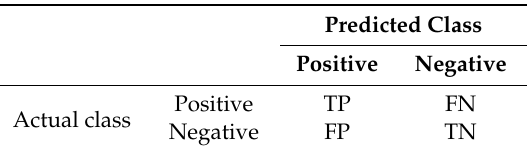
Table 1. Confusion